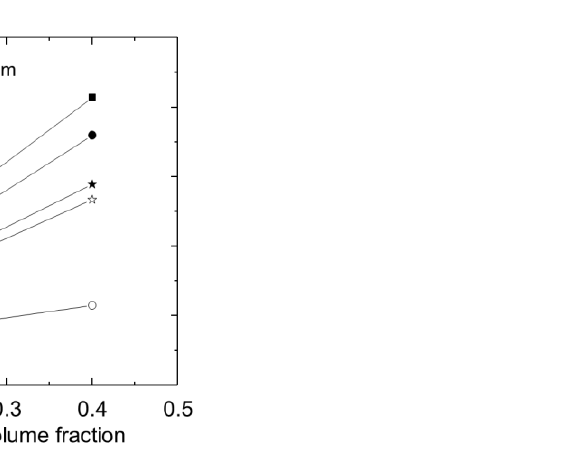
Figure 11. Strength of carbon-fibre/aluminium-matrix composites with the fibre coated by alumina. Experimental data published in [37].